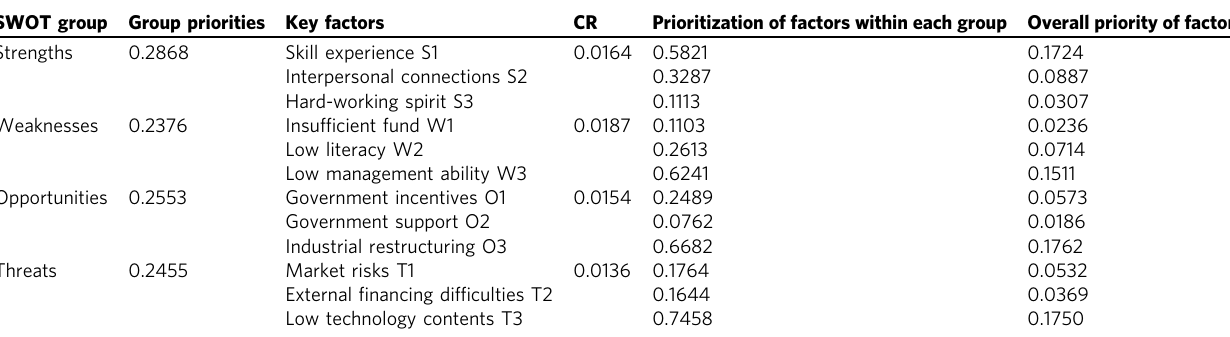
Table 5 Priority results of key factors for entrepreneurial ability of returning migrant workers. SWOT group Group priorities Key